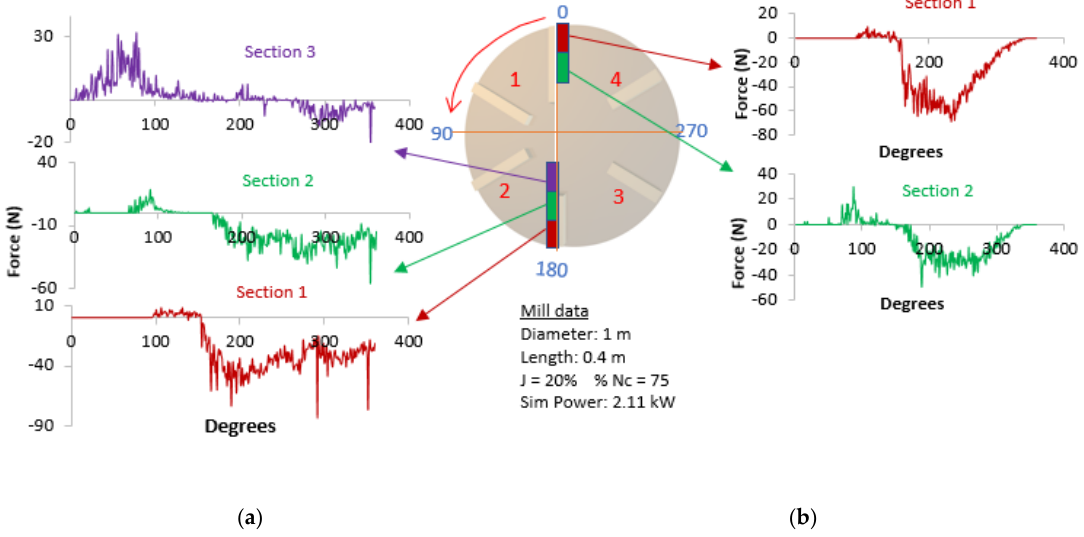
Figure 7. Comparison of tangential forces at ( a ) long end lifter ( b ) short end lifter.